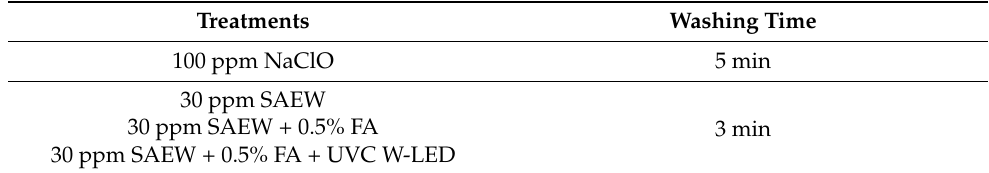
Table 1. Application conditions of each treatment for fresh-cut fruits. Treatments Washing Time 100 ppm